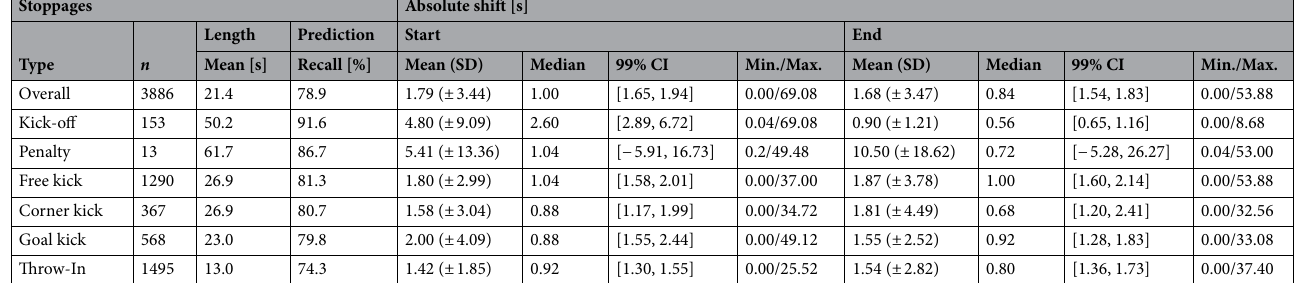
Table 2. Prediction quality per stoppage type for 3886 correct predicted stoppages in 47 test matches with AdaBoost and minimum stoppage length of 2 s. Absolute time shift to the ground truth of predicted stoppages with AdaBoost.